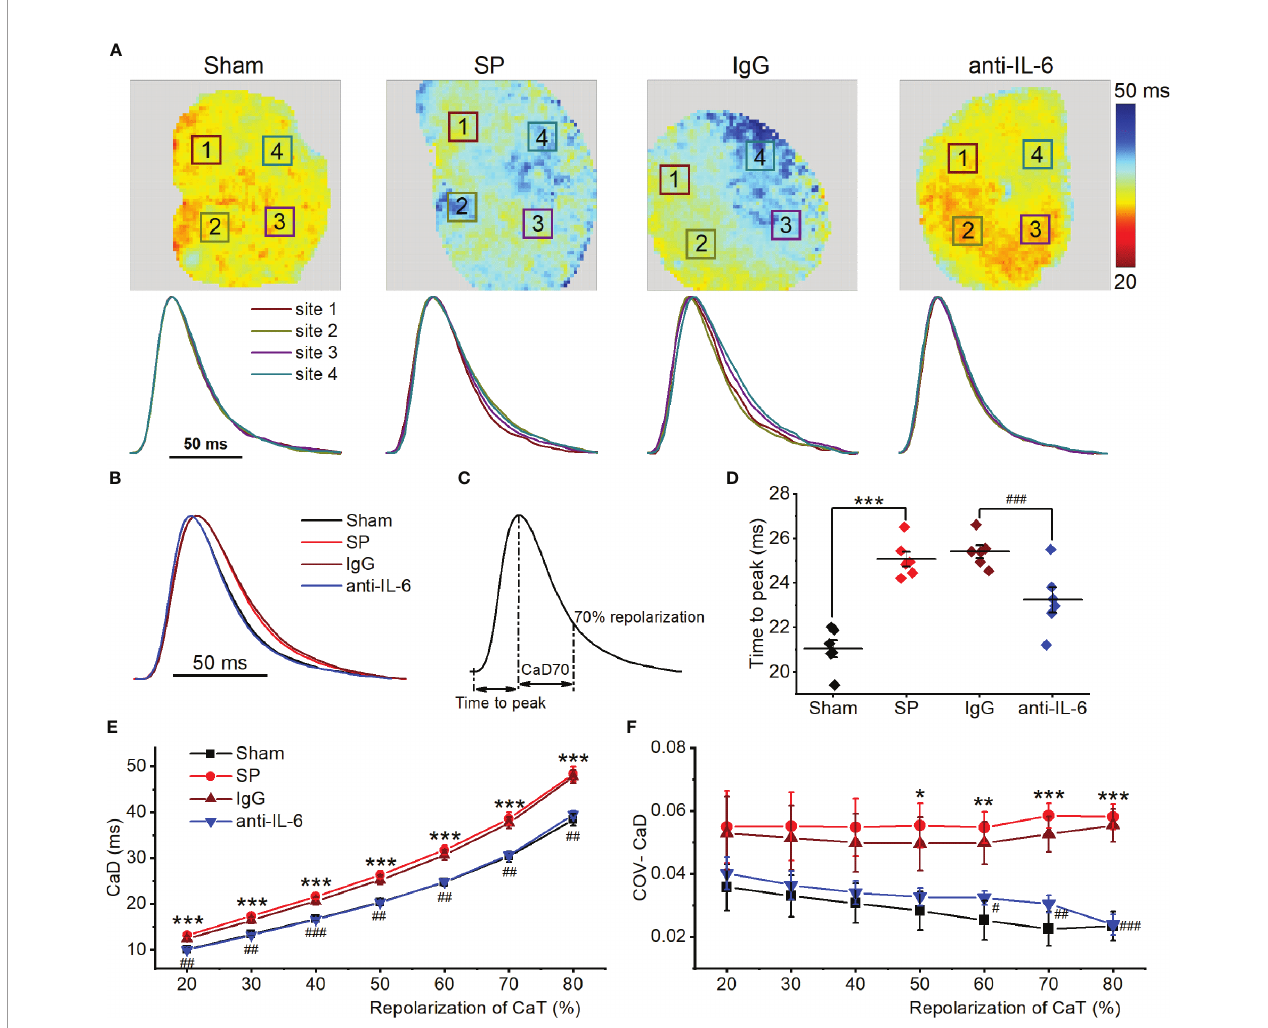
FIGURE 3 | IL-6 neutralization improves atrial Ca 2+ handling abnormalities in SP rats. (A) Atrial CaD70 maps from the 4 indicated groups at a cycle length of 142.86 ms (upper panel), and CaT traces from corresponding the 4 locations indicated with a box in the upper map (lower panel). (B) CaT traces from the 4 groups. (C) Calculation diagram of CaD. (D) Quanti fi cation of time to peak. (E, F) Quanti fi cation of CaD (E) and its coef fi cient of variation (F) . n = 6/group. *P < 0.05, **P < 0.01, ***P < 0.001 vs . Sham; # P < 0.05, ## P < 0.01, ### P < 0.001 vs . IgG, determined by Student t-test or one-way ANOVA with Bonferroni ’ s post-hoc